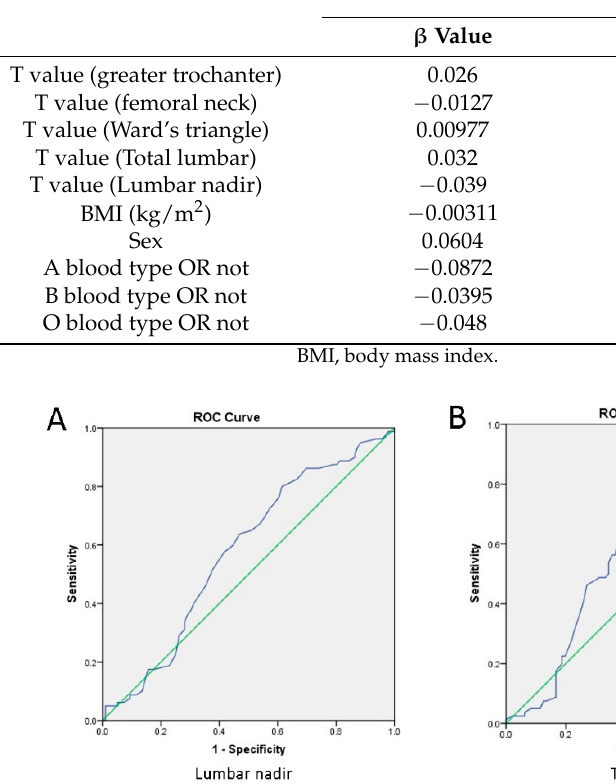
Figure 4. ROC curves for bone density in THA patients. Panel ( A ): AUCROC 0.577 (95% CI: 0.492–0.661, p = 0.08). Panel ( B ): AUCROC 0.593 (95% CI: 0.507–0.678, p = 0.035). Panel ( C ): AUCROC 0.603 (95% CI: 0.519–0.688, p = 0.018).